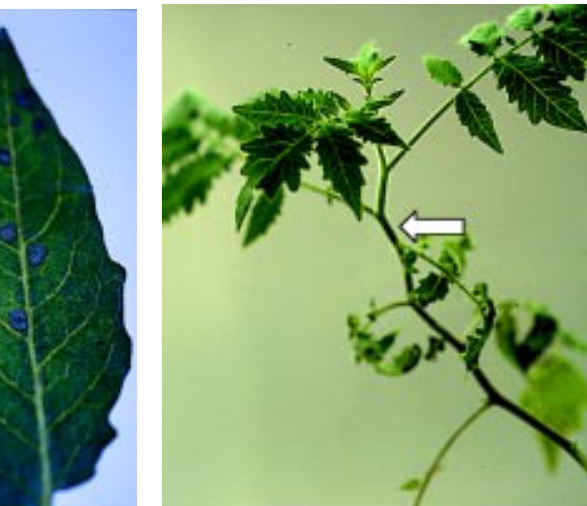
Fig. 2. Hypersensitive lesions in leaves mechani- cally inoculated with TSWV from a tomato plant with the Sw5 gene.